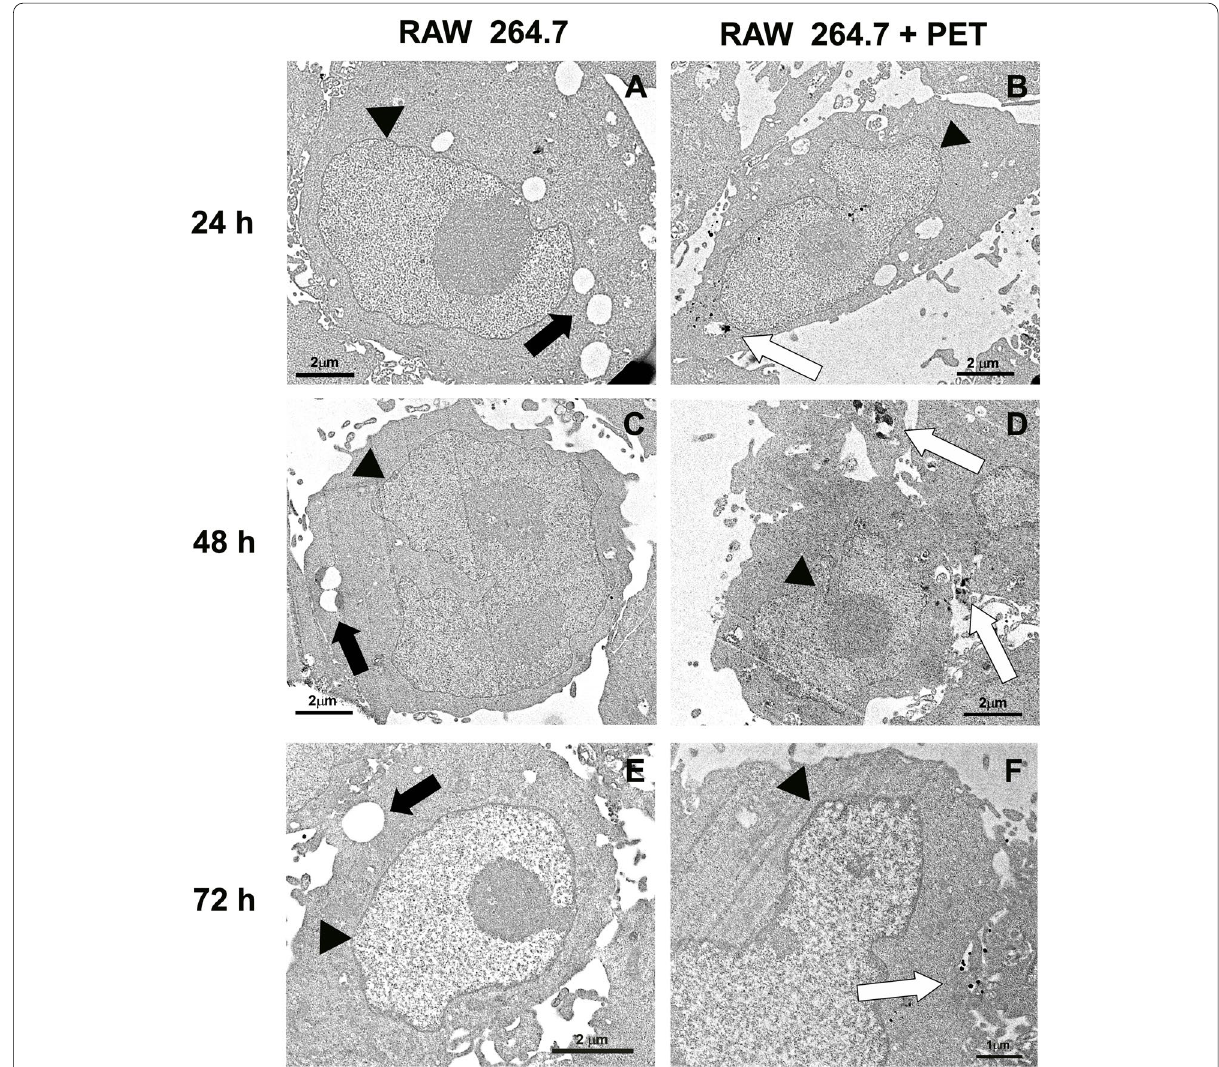
Fig. 5 PET‑NPs internalization. TEM micrography of RAW 264.7 cell line control ( A , C , E ) and exposed for 24, 48, and 72 h to 15 µg/mL PET‑NPs concentration ( B , D , F ). The black head arrows point out the nucleus, the black arrows the endosomes, and the white arrows the endosomes with PET‑NPs